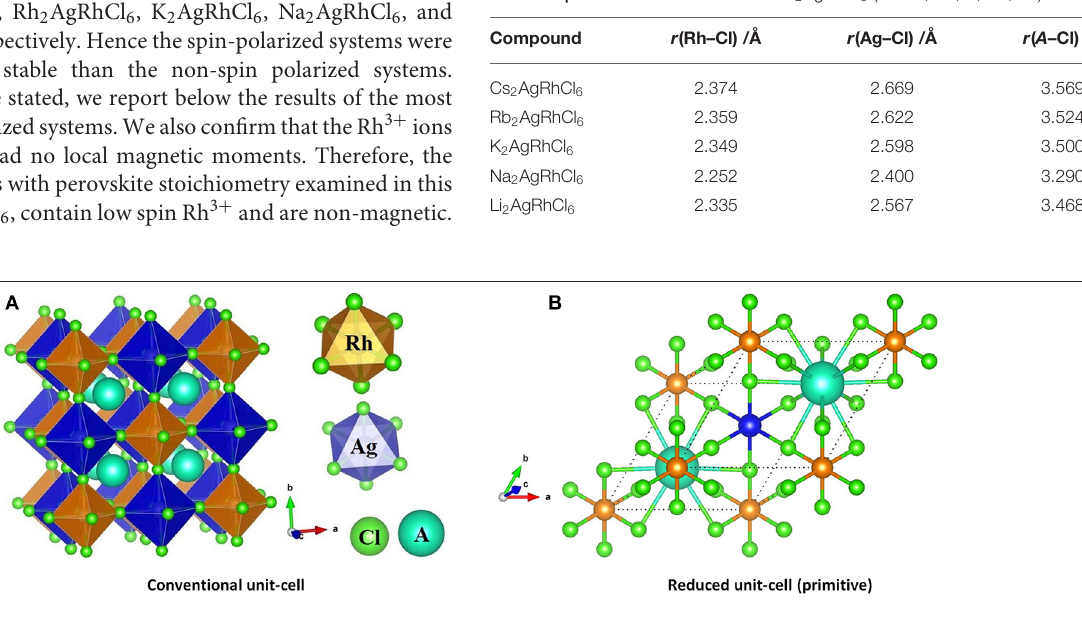
FIGURE 1 | (A) SCAN- rVV 10 relaxed polyhedral model of the conventional unit-cell of A 2 AgRhCl 6 , showing the coordination between the alkali metal anion and the halide anions. (B) The (reduced) primitive cell contains one unit of each of RhCl 6 and AgCl 6 octahedra in a face-centered cubic structure (space group Fm ¯ 3 m ).